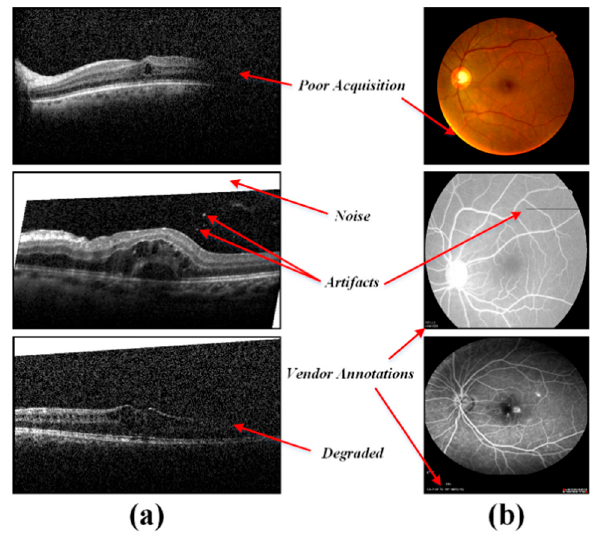
Figure 5. Degraded retinal scans. ( a ) OCT Scans and ( b ) fundus / fluorescein angiography (FA) scans.